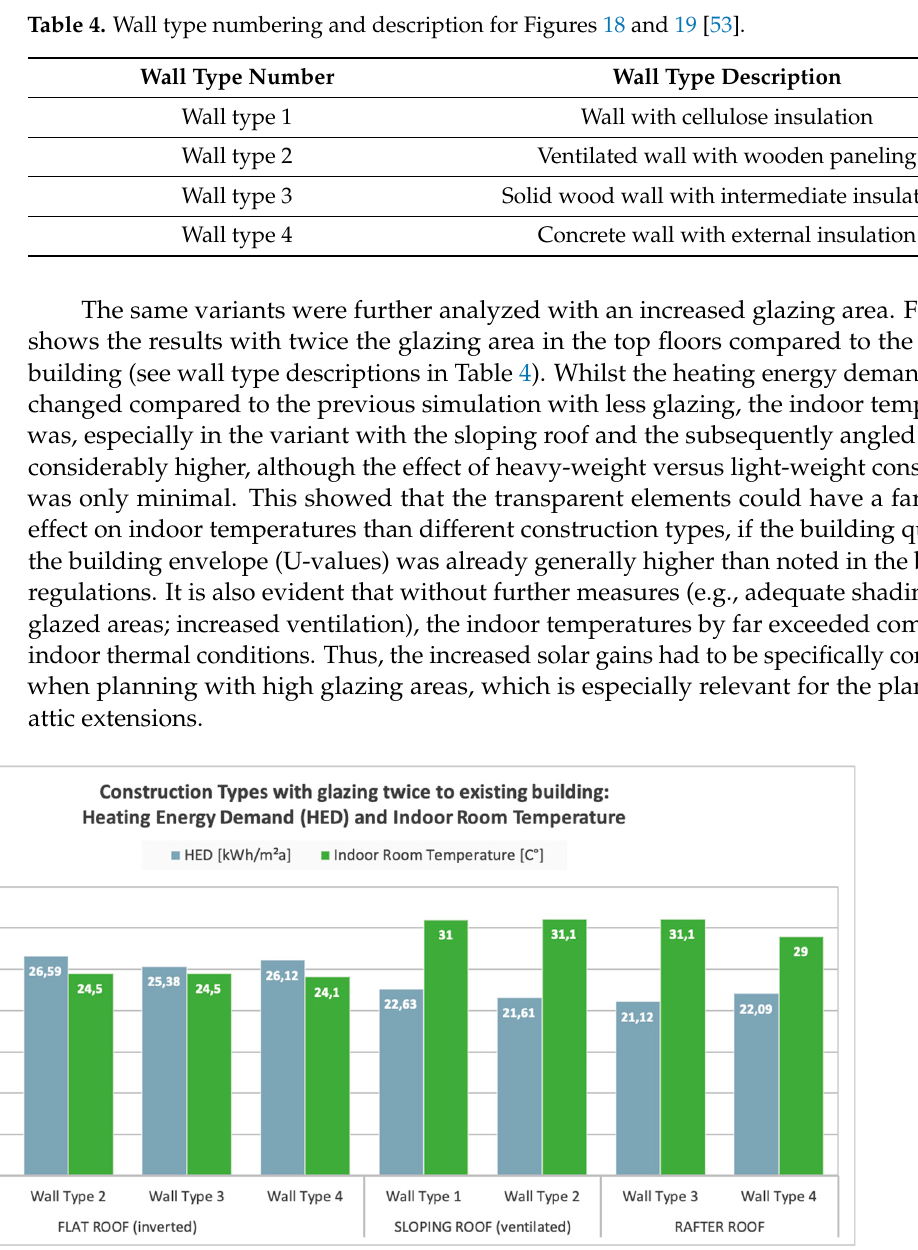
Figure 19. Heating energy demand and indoor room temperature for construction types with glazing twice to existing building (for wall type description see Table 4) [53].